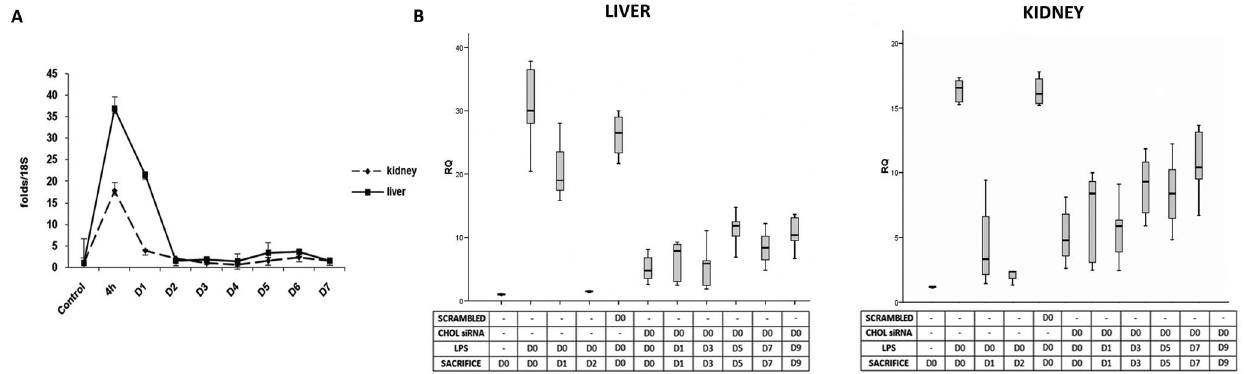
Figure 2. In vivo CD40 expression after LPS stimulus and Chol-siRNA. A) ) Kinetic of CD40 expression in liver and kidney after LPS injection, a peak of CD40 expression at 4 h was seen. There were no differences using scrambled siRNA. B) Pharmacodynamic evaluation of Chol-siRNA. Mice receiving a single dose of Chol-siRNA at day 0 and a single injection of LPS at pre determined time points showed reduction on liver and kidney CD40 gene expression. Data are expressed as mean 6 SEM of four separate